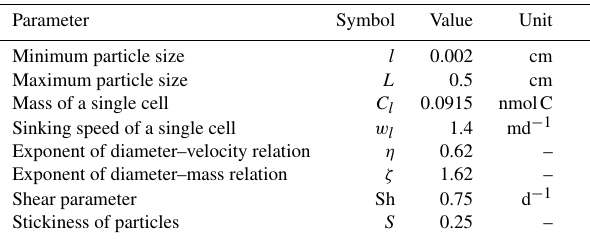
Table 3. Parameter values adopted for the prognostic sinking speed